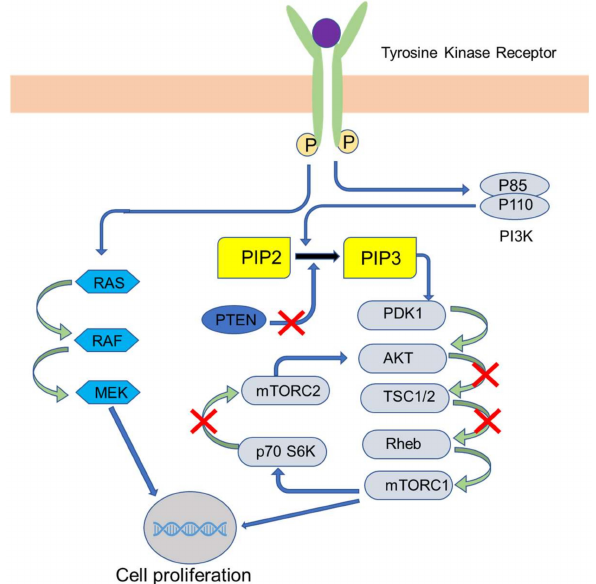
Figure 3. Schematic representation of the mechanism of the phosphatidylinositol 3-kinase (PI3K) / protein kinase B (AKT) / mammalian target of rapamycin (mTOR) pathway. PI3K—phosphatidylinositol